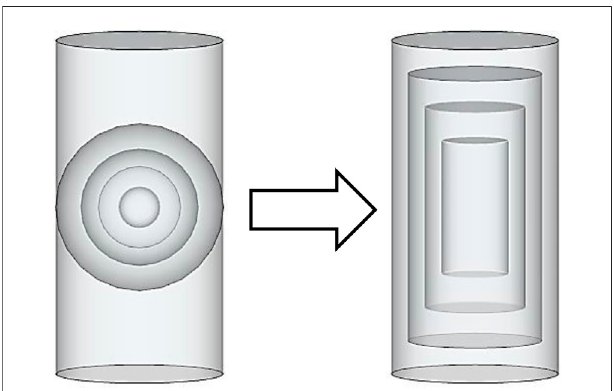
FIGURE 11 | Sphere and cylinder-covering